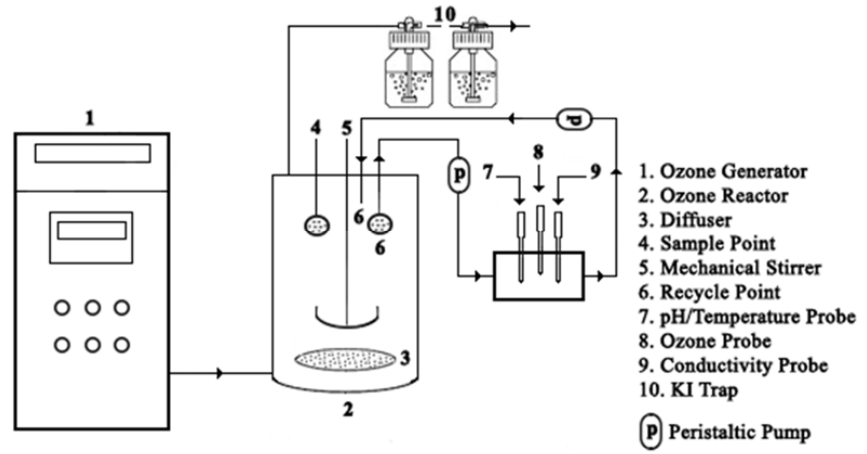
Figure 16. Experimental setup.